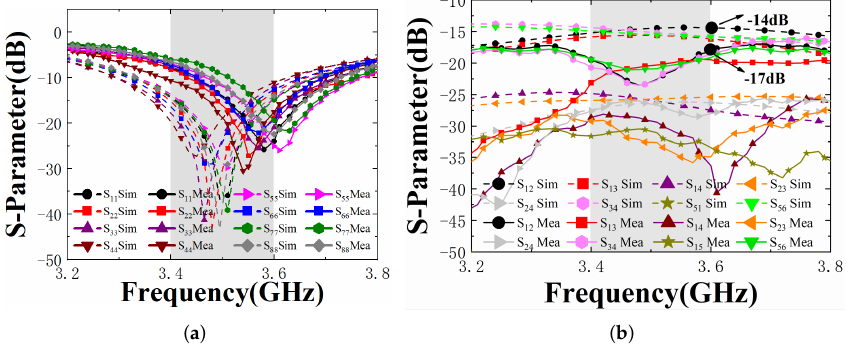
Figure 9. Simulated and measured S-parameter of the proposed antenna. ( a ) Reflection coefficients.